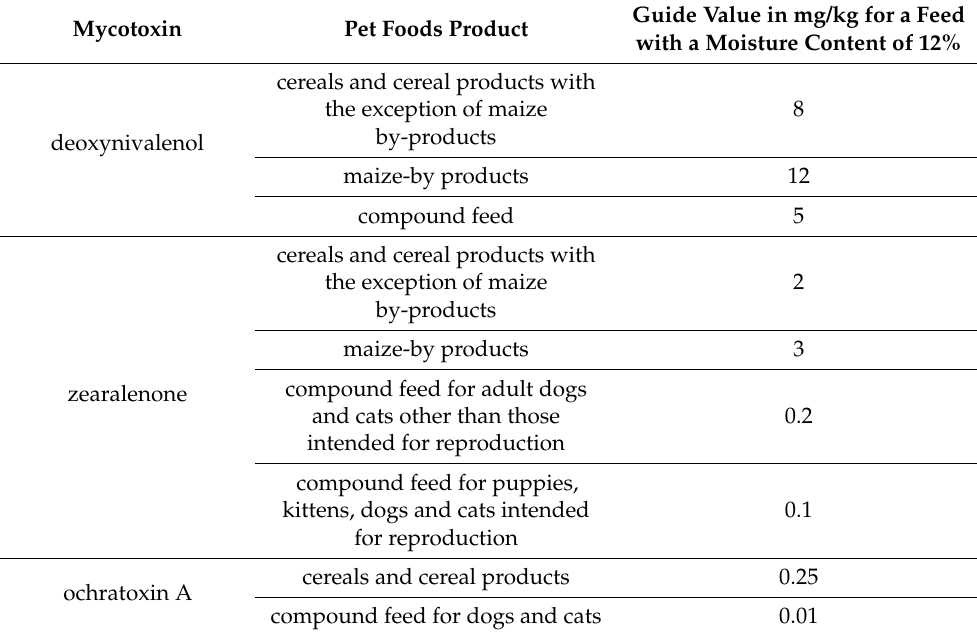
Table 1. Guideline limit values for deoxynivalenol, zearalenone, ochratoxin A in pet products [54]. Guide Value in mg/kg for a Feed Mycotoxin Pet Foods Product with a Moisture Content of 12% cereals and cereal products with the exception of maize 8 by-products deoxynivalenol maize-by products compound feed